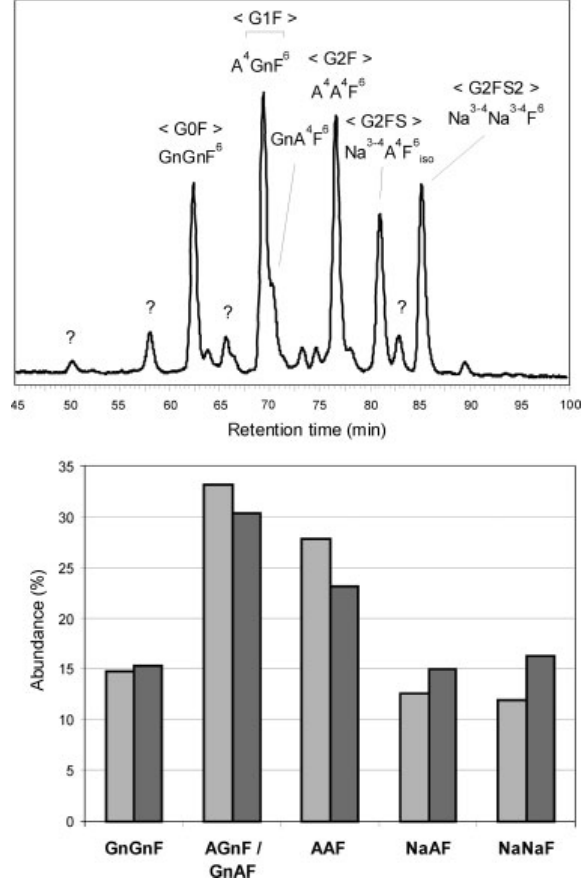
Figure 6. Comparison of PGC-MS with NP-HPLC: (A) chromato- gram of AB-labeled glycans from CHO-derived 4E10. The peaks are labeled both with proglycan names and according to the “Oxford system” [7], where G stands for galactose, F for fucose, and S for sialic acid. A number of peaks (some marked “?”) remained unidentified. Some of these could be defucosylation artifacts of major compounds. The bar encompasses the two isomers to which the term “G1F” applies. (B) Comparison of the quantities of the major compounds as obtained with the two methods. Dark bars represent the results from a single NP-HPLC run. Light bars are the results of three analyses (including SDS- PAGE) by RPC-MS with SDs of 0.6% or less (notably for the major peaks of a pure protein). Structure abbreviations are given with- out linkage